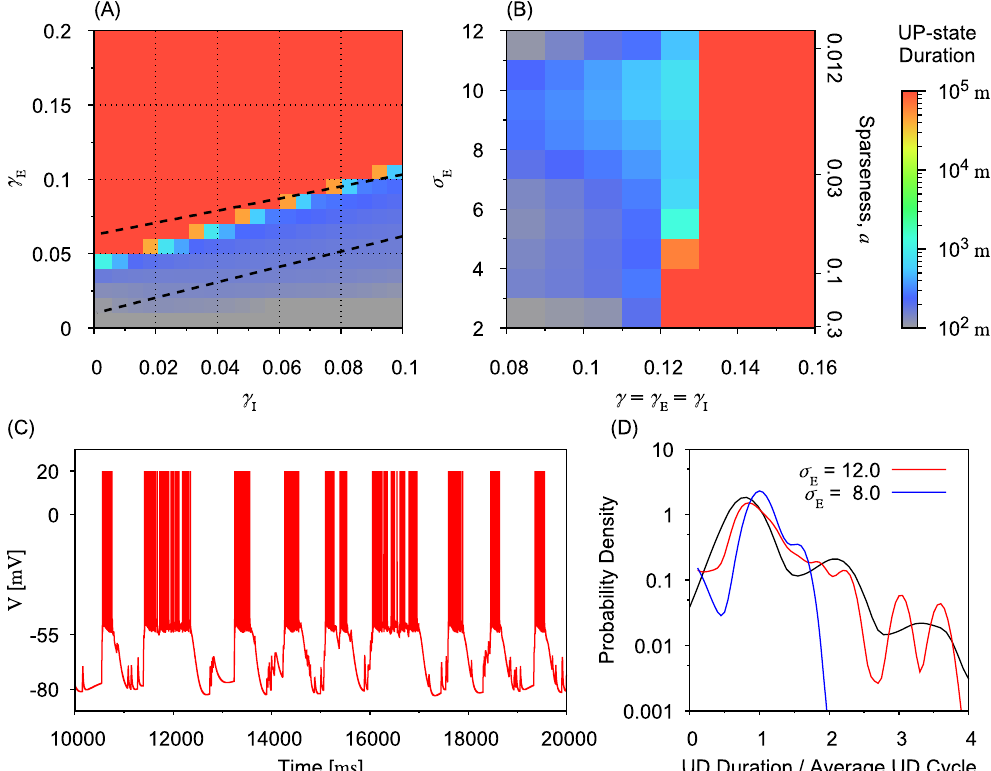
Figure 6. Statistics of UP-DOWN cycle for sparse-log-normal weight configurations. ( A ) The average duration of UP-states is shown for various values of γ E and γ I at b u = 50 pA in a sparse-log-normal network of size N E = 1000. The upper dashed curve is the predicted boundary from the mean-field analysis for self-sustainable UP states, while the lower dot-dashed curve is the predicted boundary for the presence of the slow oscillations. Sparse-log-normal random connection weights have the fixed variance of 1 E2 σ = . ( B ) The average duration of UP states at b u = 200 pA is shown for various values of connection weight factor γ and excitatory variance E2 σ in a network of size N E = 1000. ( C ) An example of the membrane trace is shown, which showed a sequence of transient UP states. Parameter values were set as N E = 1000, γ = 0.11 and σ E = 12.0. ( D ) Distributions of the UP- state duration of transient UP states normalized by the average UP-state duration are shown for σ E = 12.0 (green) and σ E = 8.0 (blue). Black curve shows the experimental result reported in 4 . Reprinted by permission from Macmillan Publishers Ltd: Springer Nature. Nature Neuroscience. Spontaneous persistent activity in entorhinal cortex modulates cortico-hippocampal interaction in vivo , T. T. Hahn et al ., copyright (2012). Parameter values were set as a u = 4.0 nS, b u = 50.0 nS and γ = γ E = γ I =